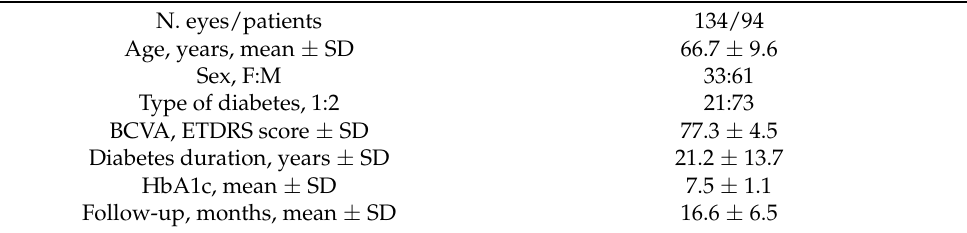
Table 1. Patients’ clinical and demographic characteristics at